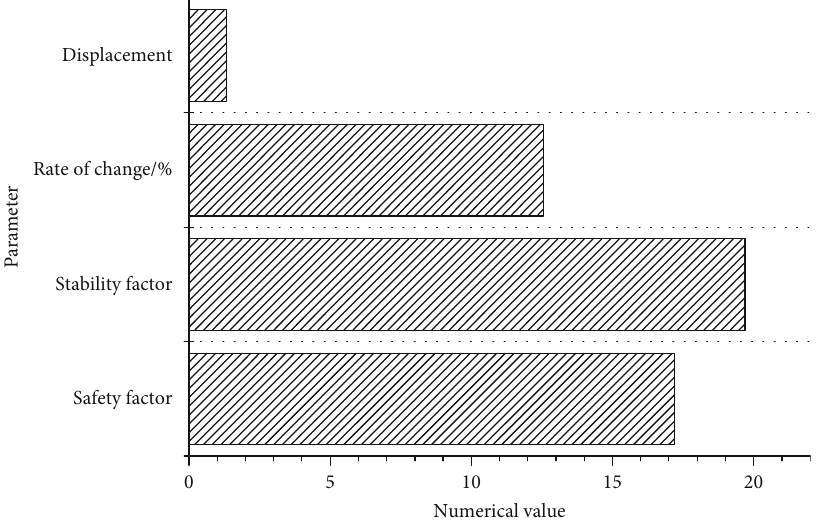
Figure 12: Comparison of two geometric nonlinear risks.